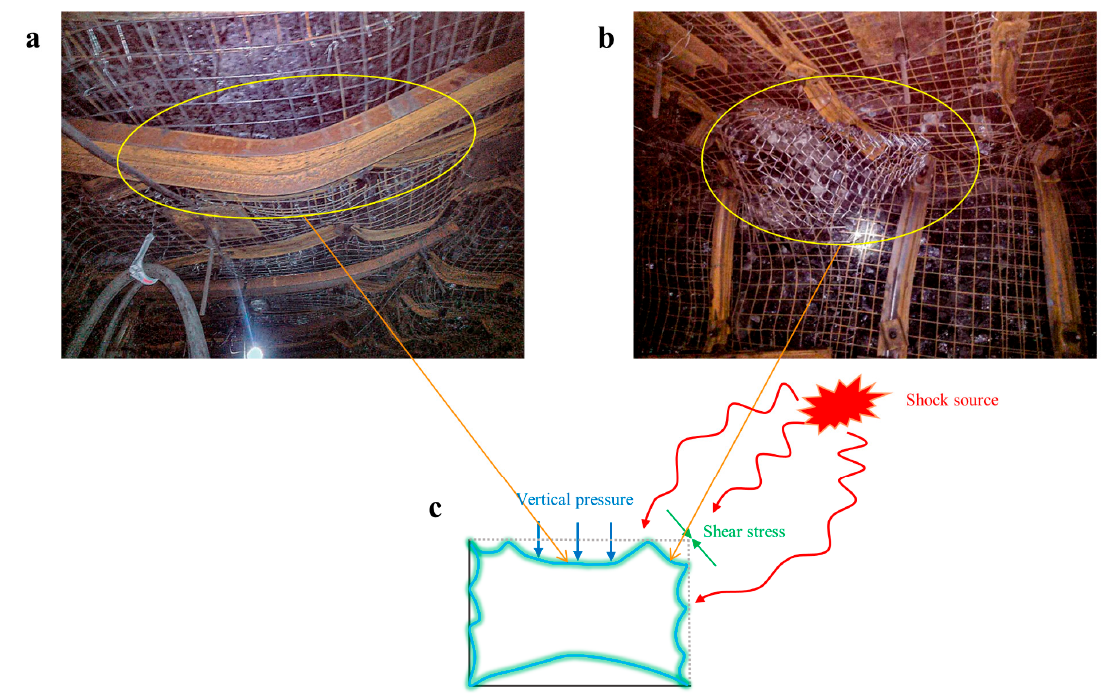
Figure 2. Damage characteristics of the roadway: ( a ) roof failure; ( b ) rib and corner damage; ( c ) roadway contour.